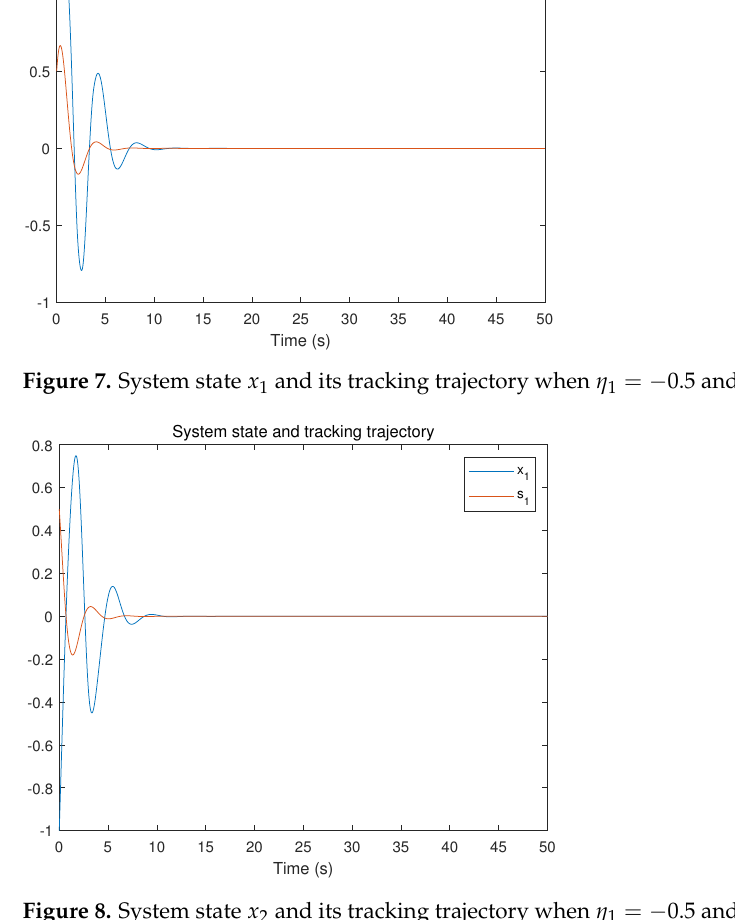
Figure 8. System state x 2 and its tracking trajectory when η 1 = − 0.5 and η 2 =